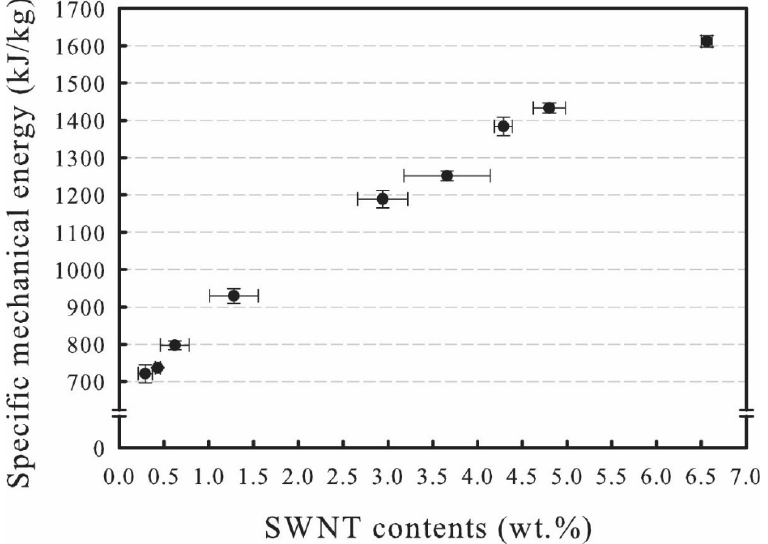
Figure 2. Specific mechanical energy applied to produce composites with different SWNT content.